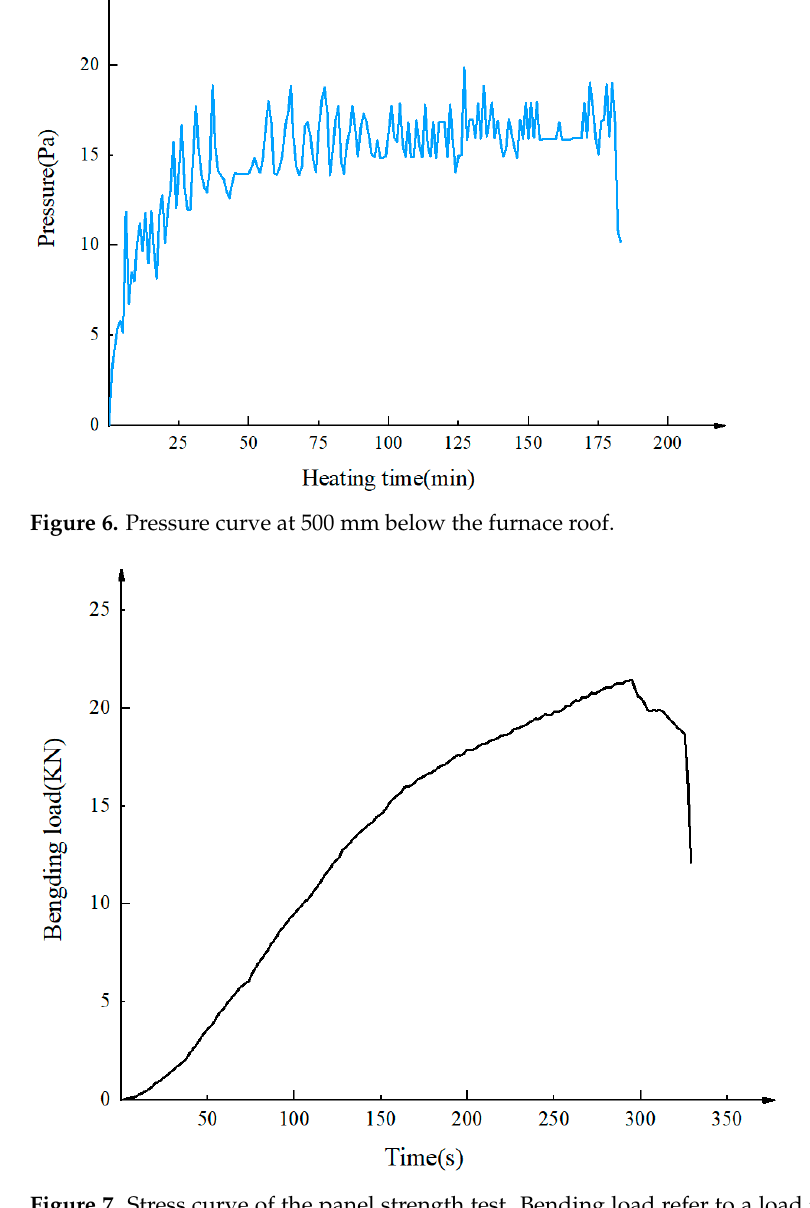
Figure 7. Stress curve of the panel strength test. Bending load refer to a load that causes bending deformation of a panel during a fixed strength test.